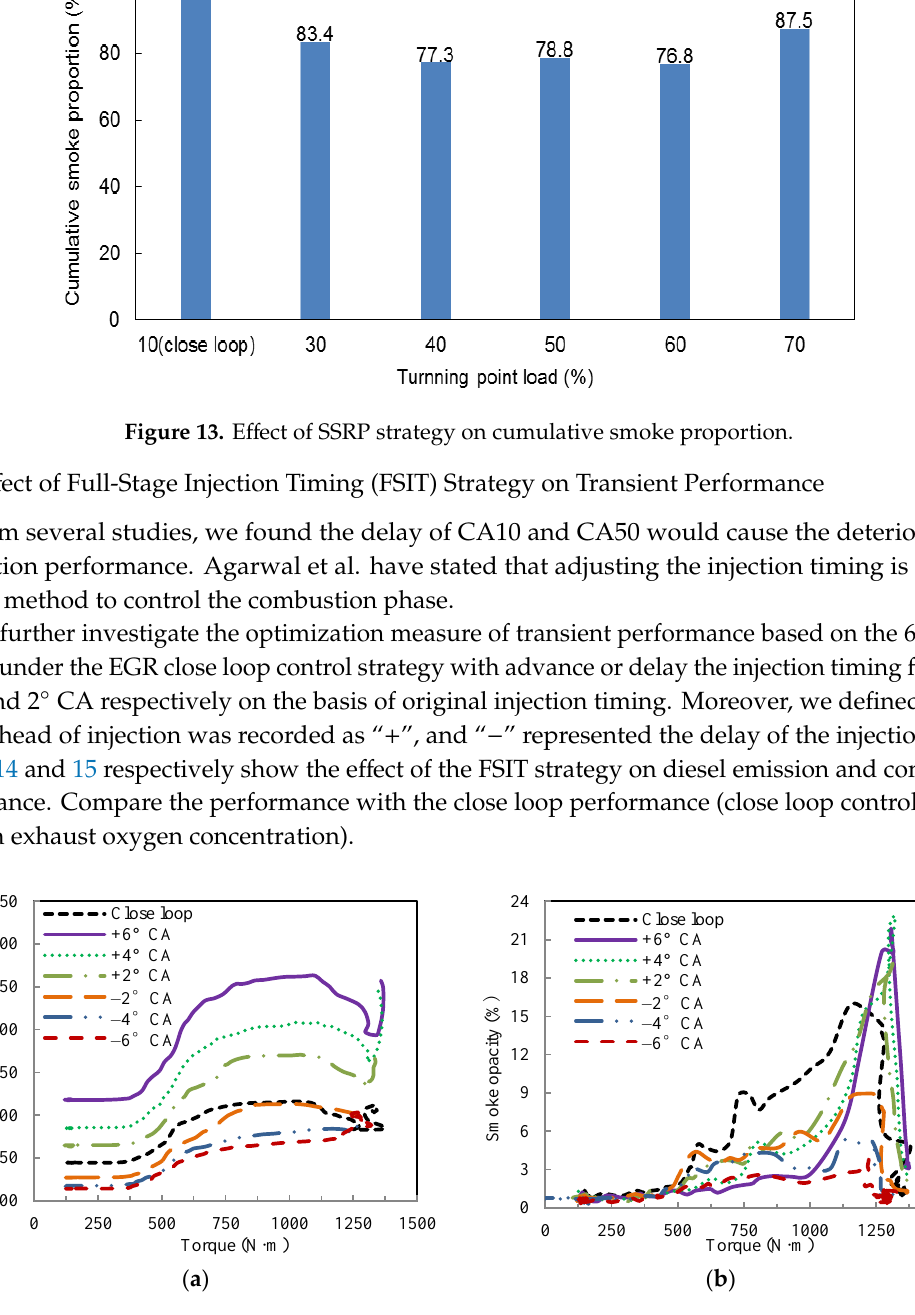
Figure 14. Effect of full-stage injection timing (FSIT) strategy on transient performance: ( a ) NOx; ( b ) smoke opacity.